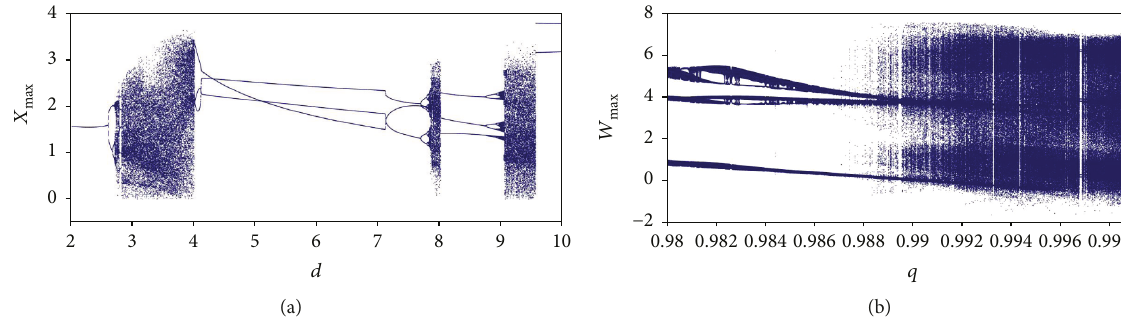
Figure 3: (a, b) The bifurcation of the FOPCC system with d